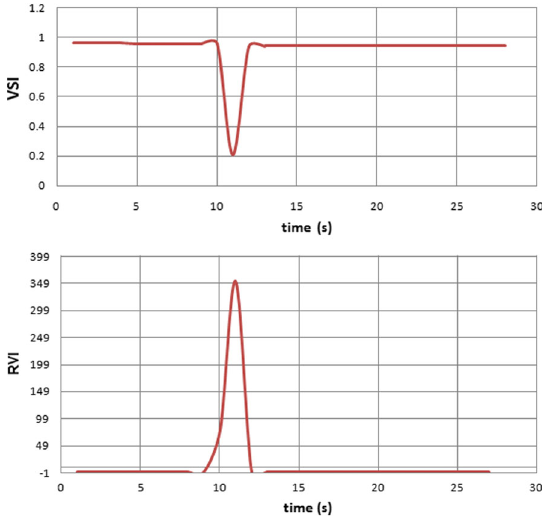
Fig. 15 VSI and RVI of MC bus on SPS initiation